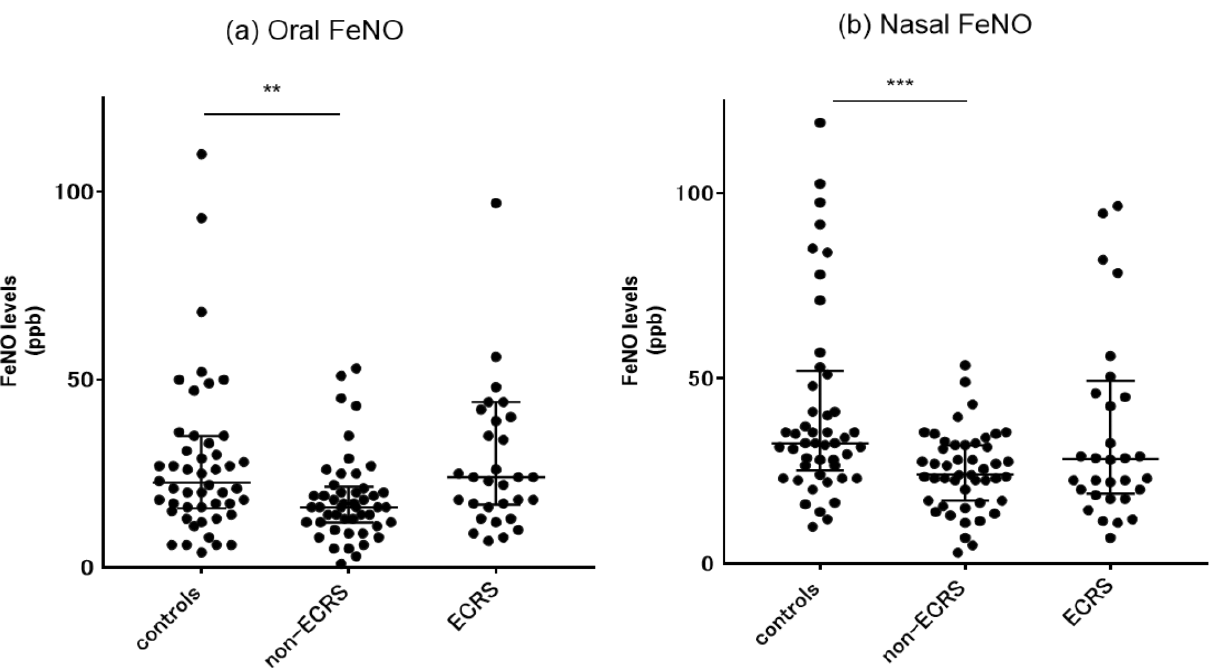
Figure 5. ( a ) Oral FeNO and ( b ) nasal FeNO levels in control subjects and non-ECRS and ECRS patients. ** p < 0.01; *** p < 0.001; FeNO, fractional exhaled nitric oxide. Center lines, median values; error bars, interquartile ranges.